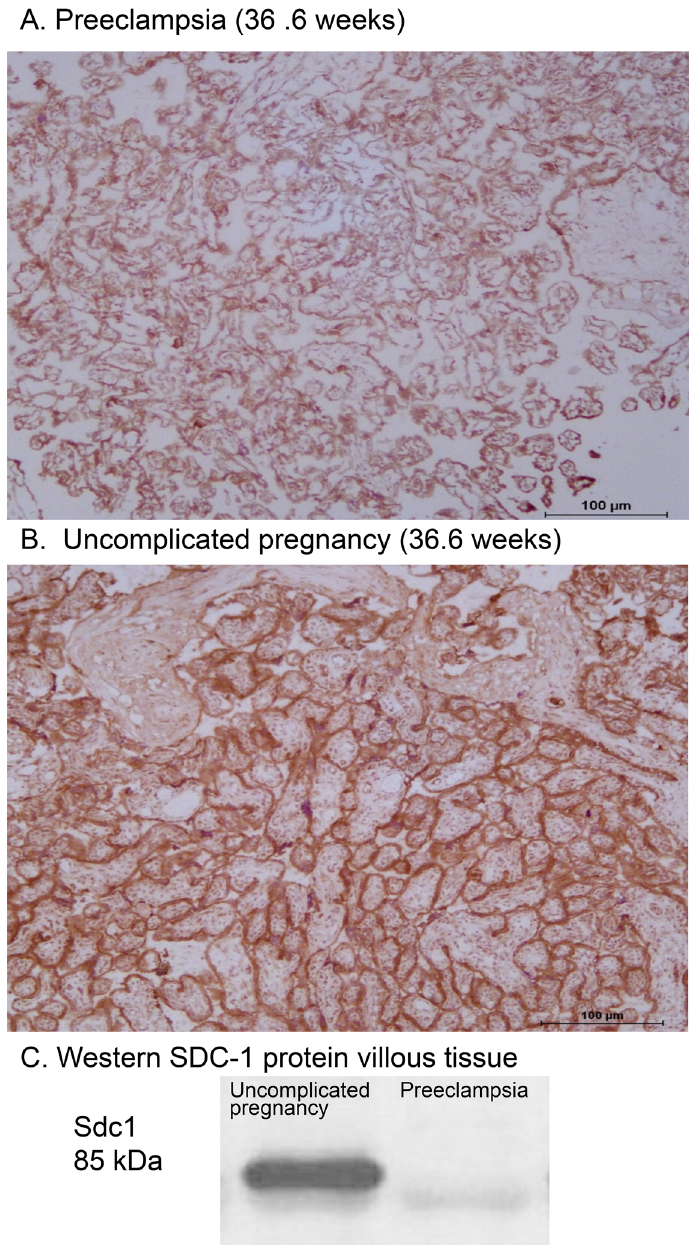
Fig 3. Representative images of Sdc1 immunoreactivity in preeclampsia (A) compared to uncomplicated pregnancy (B) villous tissue. Note the more intense staining on syncytiotrophoblast of uncomplicated pregnancy (immunohistochemical score = 4) compared to preeclampsia (score = 1), and apparent absence of staining in fetal villous vasculature throughout. Gestational age at delivery was 36.6 weeks for both placentas. C: Sample Western blot of villous tissue homogenates from the preeclampsia and control patients; band densities at the expected 85 kDa are consistent with reduced Sdc1 protein mass in preeclampsia. See also Table 3 for summary group data. detected on fetal villous vasculature (Fig 3). There was no discernable between-group differ- ence in localization of the protein. The Sdc1 intensity score for Sdc1 on syncytiotrophoblast was significantly lower in preeclampsia (n = 19) [2.0 (1.0 – 3.5)] vs. controls (n = 25) [(3.0 (1.0 –